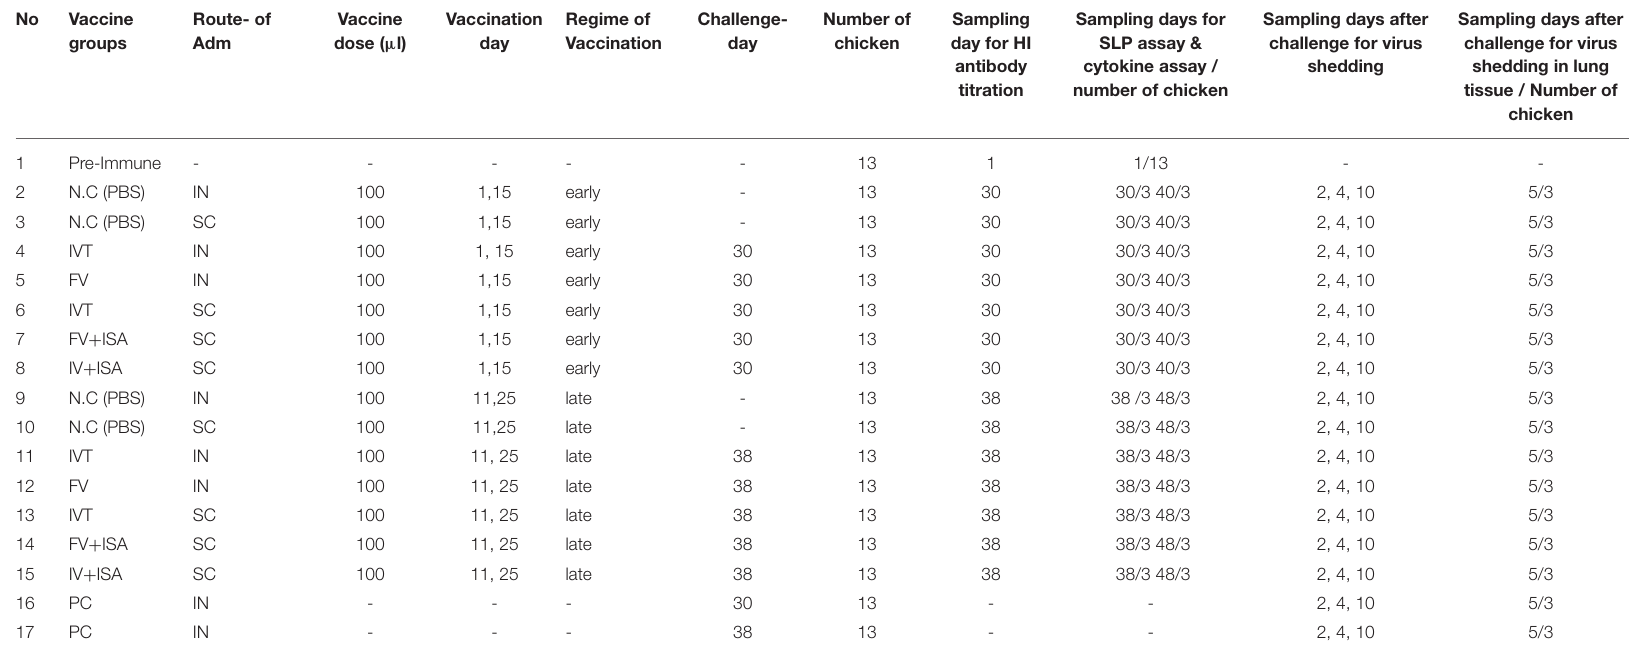
TABLE 1 | The second design for the chicken